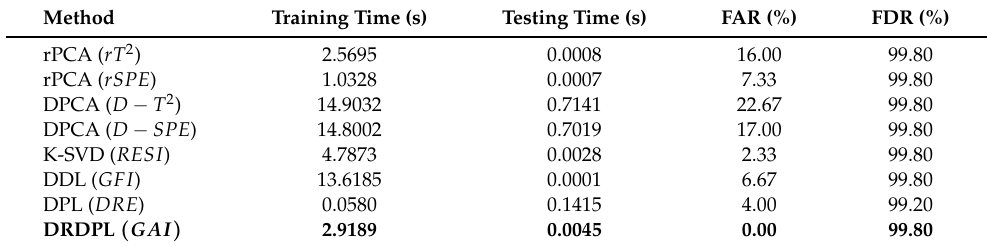
Table 4. The comparison results of TE process with IDV (6).